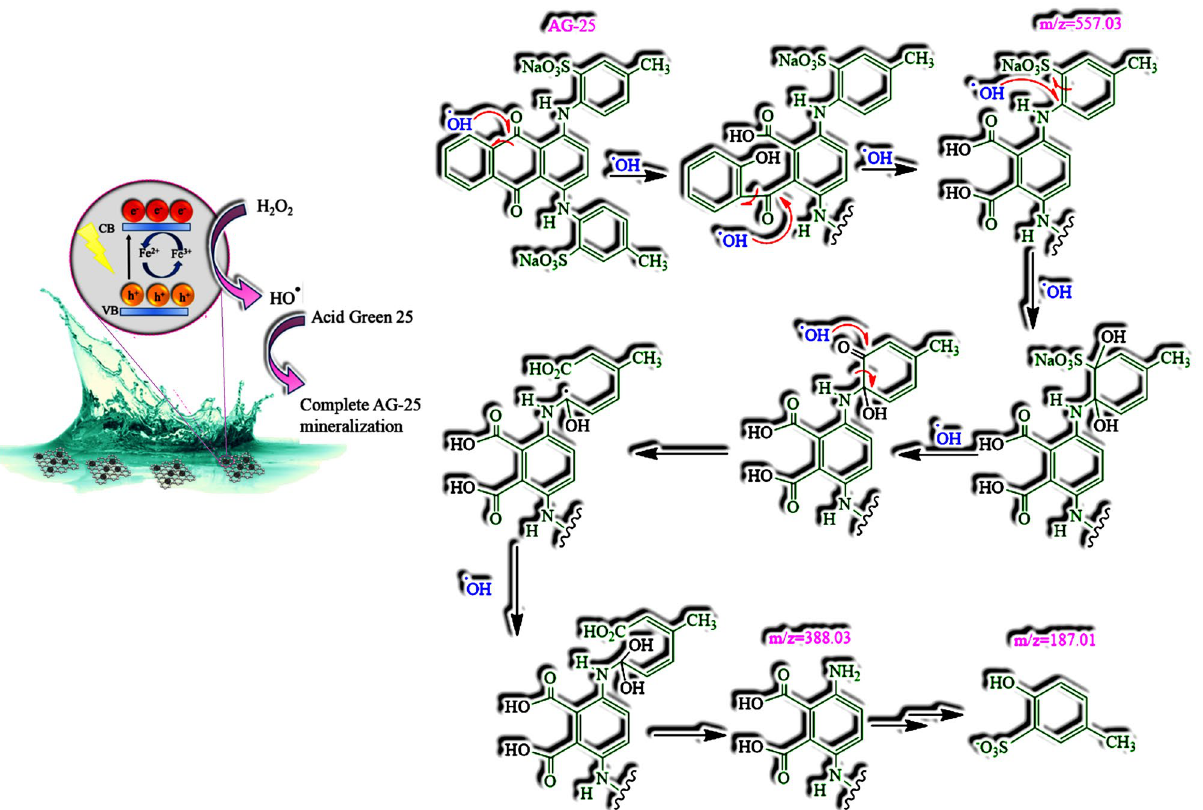
Figure 15 . Proposed mechanism of AG-25 degradation in the 3D rGO/Fe 3 O 4 /H 2 O 2